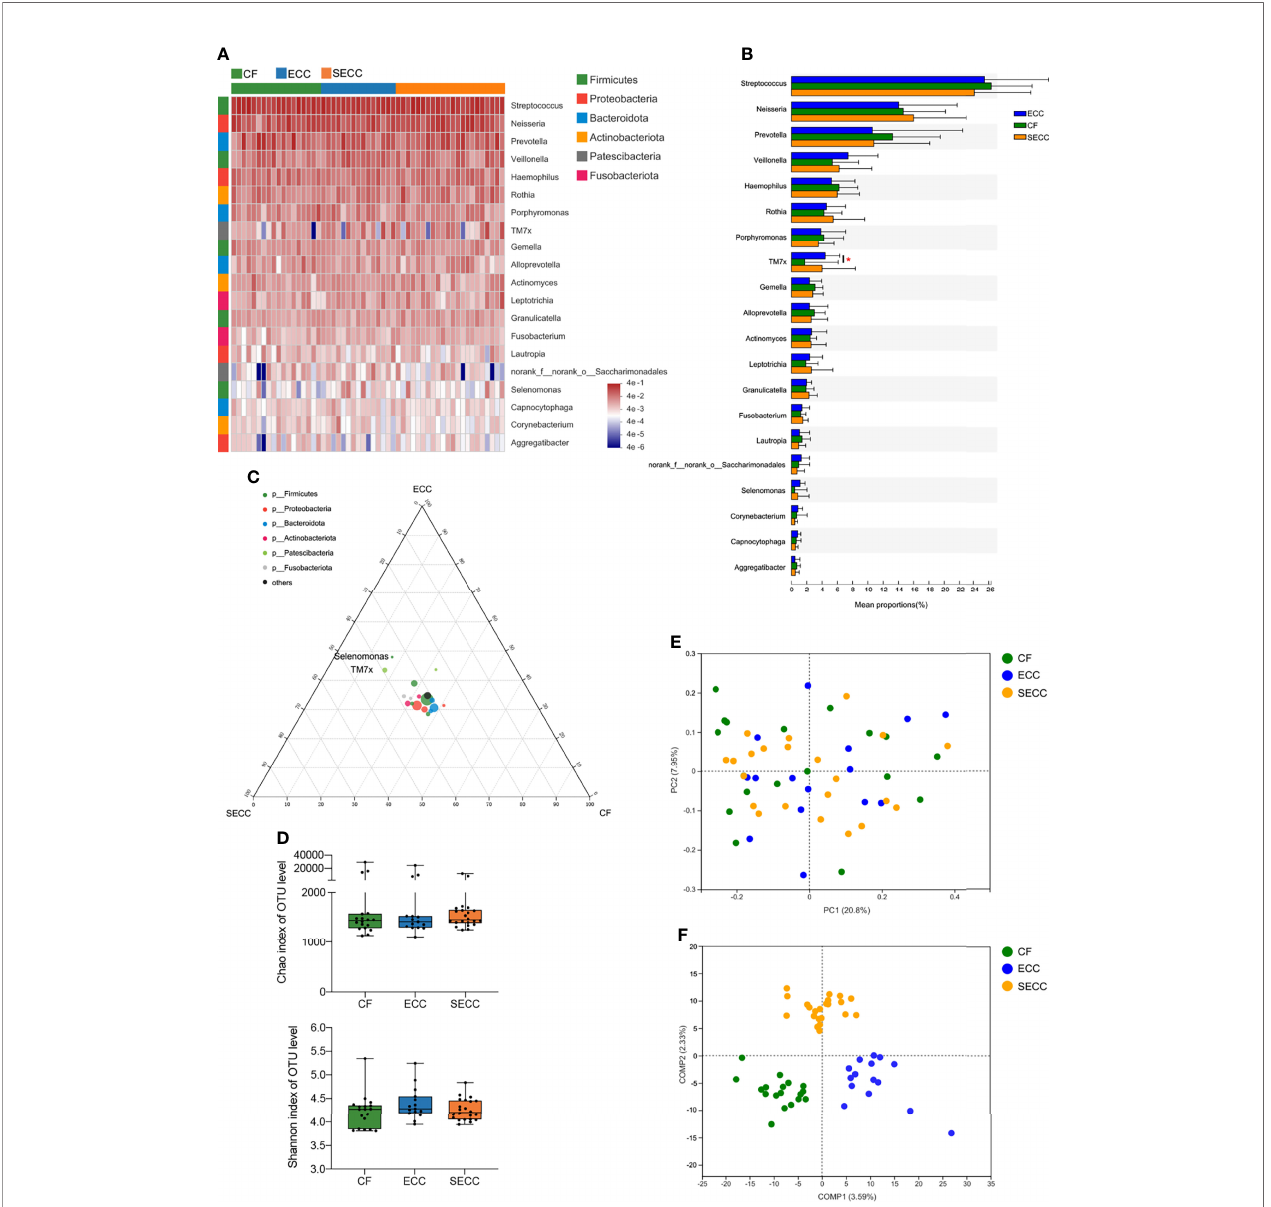
FIGURE 1 | Salivary bacterial pro fi le in children with different health conditions. (A) Overview of the 20 most abundant salivary genera, and the heatmap plot presents the common logarithm of relative abundance. (B) Statistical comparison of the relative abundance of the 20 most abundant genera (Kruskal – Wallis, among three groups; Wilcoxon rank-sum test, within two groups; * p < 0.05). (C) The relative occurrence of genera (circles) in samples with different oral health conditions. (D) Alpha-diversity indices for richness (Chao index, Kruskal – Wallis, p = 0.351) and diversity (Shannon index, Kruskal – Wallis, p = 0.351) of the bacterial community on the OTU level. (E) Principal coordinates analysis (PCoA) plots of Bray – Curtis dissimilarities at the OTU level (PERMANOVA, p = 0.771). (F) Partial least square discriminant analysis (PLS-DA) plot of saliva microbiota. CF, caries free; ECC, early childhood caries; OTU, operational taxonomic unit; PCoA, principal coordinates analysis; PERMANOVA, permutational multivariate analysis of variance; PLS-DA, partial least square discriminant analysis; SECC, severe early childhood